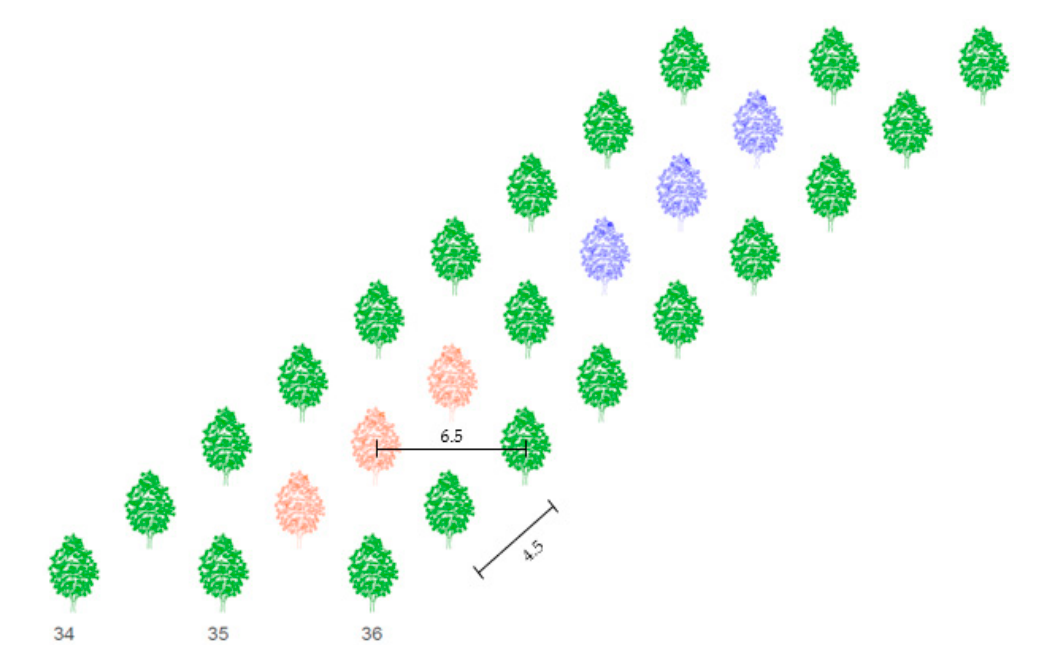
Figure 2. Scheme of spacing (m) between trees in the orchard and sample trees in row 35. Red color represents non-irrigated trees (treatment A), blue color represents irrigated trees (treatment B). Crop